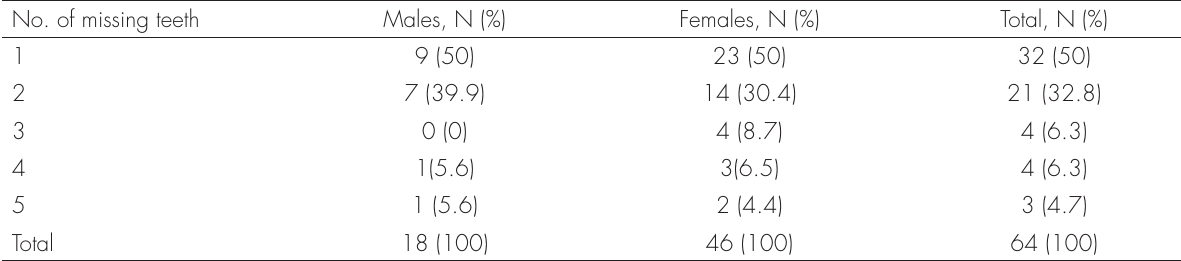
Table II. Number of missing teeth and frequency No. of missing teeth Males, N (%)